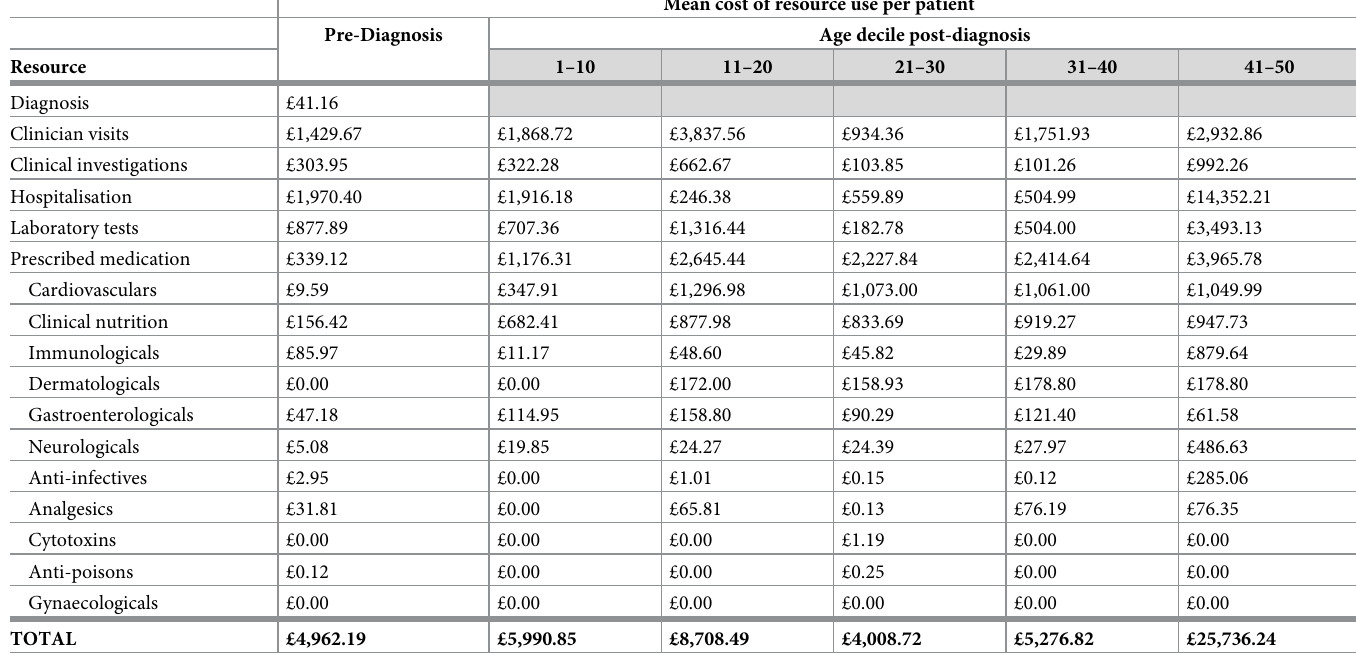
Table 7. NHS cost of patient management at 2014/15